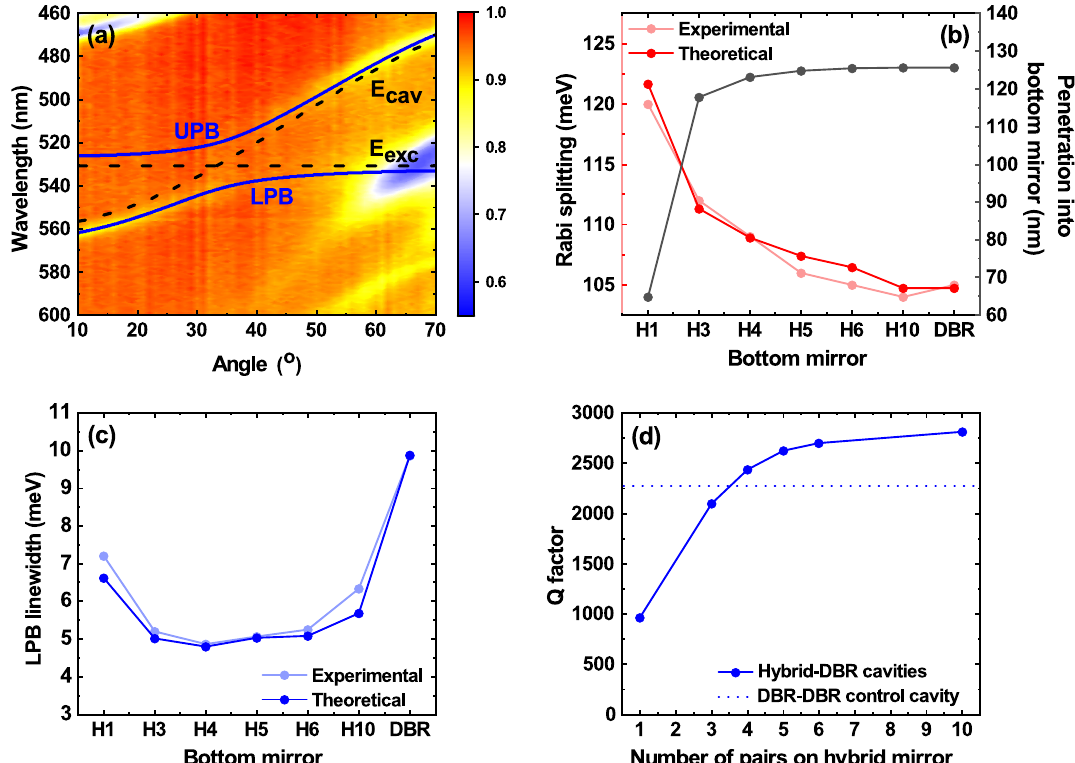
Figure 3. The effect of the number of hybrid mirror pairs on microcavity optical properties. ( a ) Plots the angle-dependent reflectivity measurement of a 4-pair hybrid mirror cavity. Fits of upper (UPB) and lower (LPB) polariton branches (blue solid lines) are made using a standard two-level oscillator model. The dispersion of the cavity photon mode (E cav ) and the exciton energy (E exc ) are also shown (black dashed lines). ( b ) Shows the Rabi splitting for the hybrid mirror cavities and the DBR control, where good agreement can be seen between experimental (light red, two-level oscillator) and theoretical (dark red, TMR) values. The modelled penetration of the electromagnetic field into the bottom mirror (grey) is also shown here. ( c ) Shows the linewidth of the LPB for the hybrid mirror and DBR cavities, comparing experimental (light blue) and theoretical (dark blue, from TMR) values. In both ( b ) and ( c ), the x-axis labels ‘H X ’ correspond to the hybrid mirrors, where X is the number of DBR pairs on top of the Ag, and ‘DBR’ corresponds to the 10-pair DBR. In ( d ), we plot the modelled Q -factor for hybrid mirror cavities with cavity mode at 547 nm. The modelled Q -factor of the DBR control cavity is indicated by a horizontal blue dotted